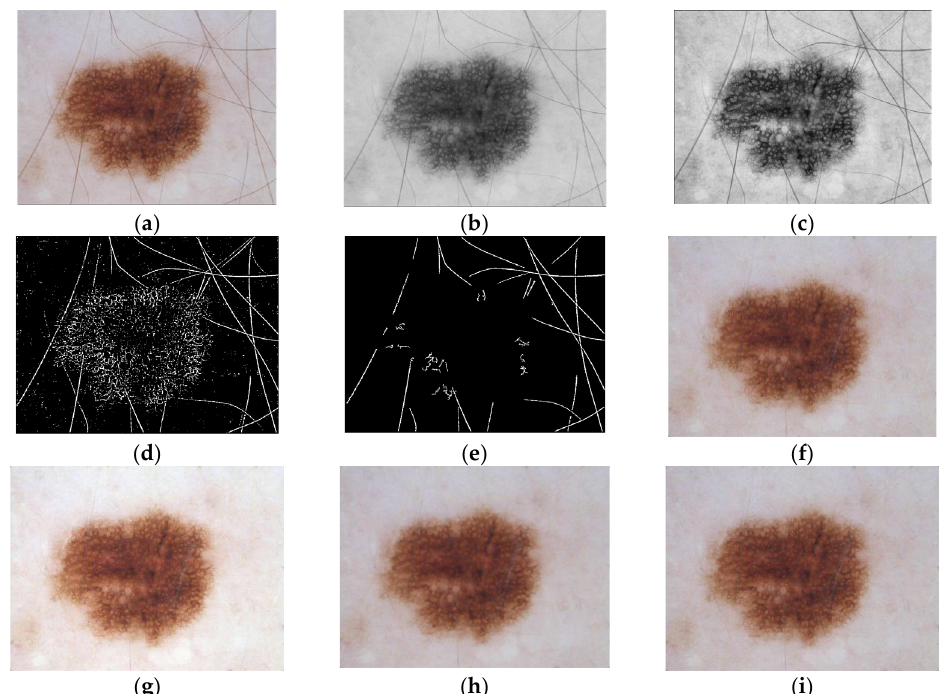
Figure 2. Qualitative analysis of the proposed hair removal system, where ( a ) original image; ( b ) the output gray image from PCA; ( c ) enhanced gray image; ( d ) binary image after thresholding; ( e ) collected mask from all iterations; ( f ) hairless image; ( g ) adaptive median filter; ( h ) 5 × 5 median filter; ( i ) 3 × 3 median filter.